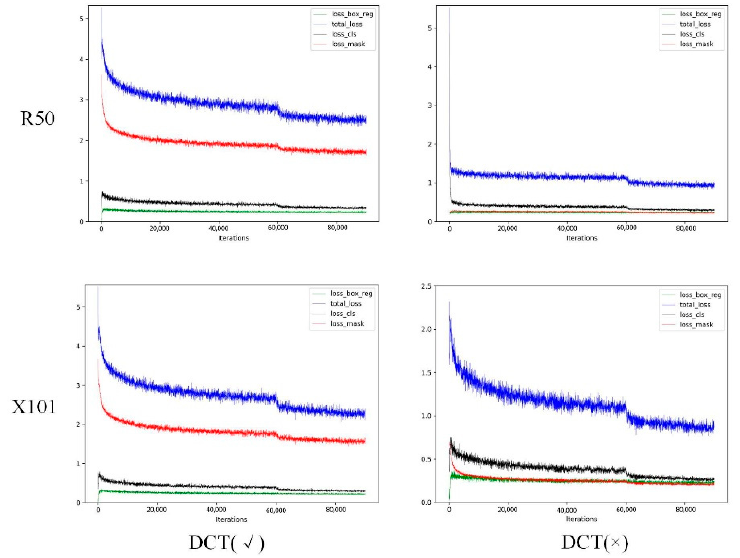
Figure 6. Effect of DCT on training loss.